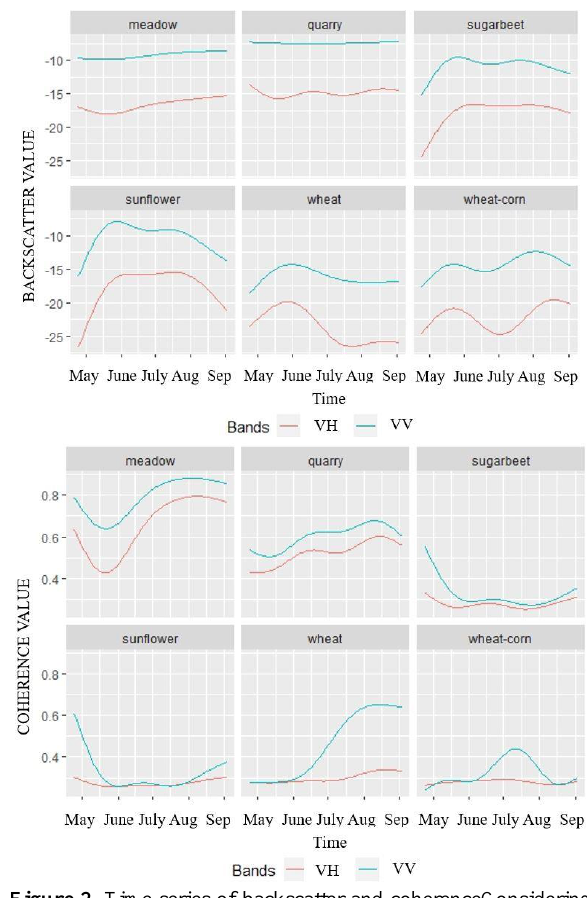
Figure 2. Time series of backscatter and